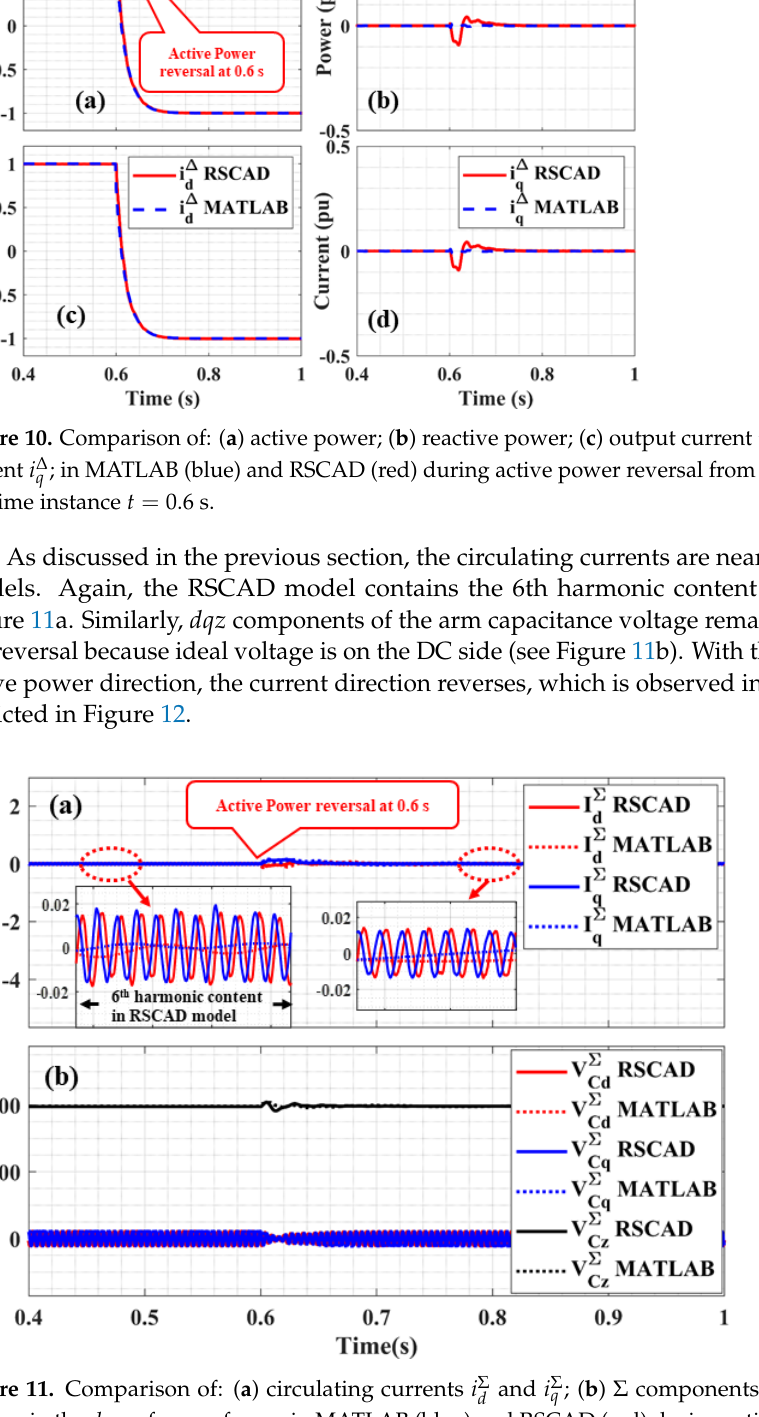
and i Σ q ; ( b ) Σ components of arm capacitor d